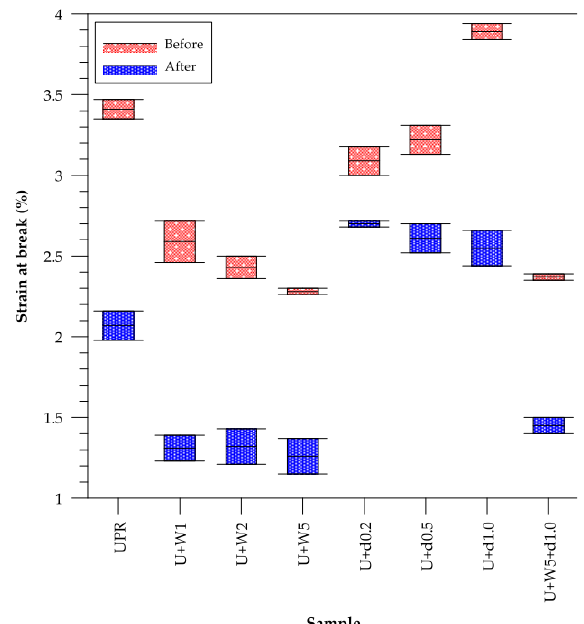
Figure 3. Mechanical data for pure UPR and composites before and after the accelerated aging test. ( a ) Flexural modulus; ( b ) flexural strength and ( c ) strain at break.